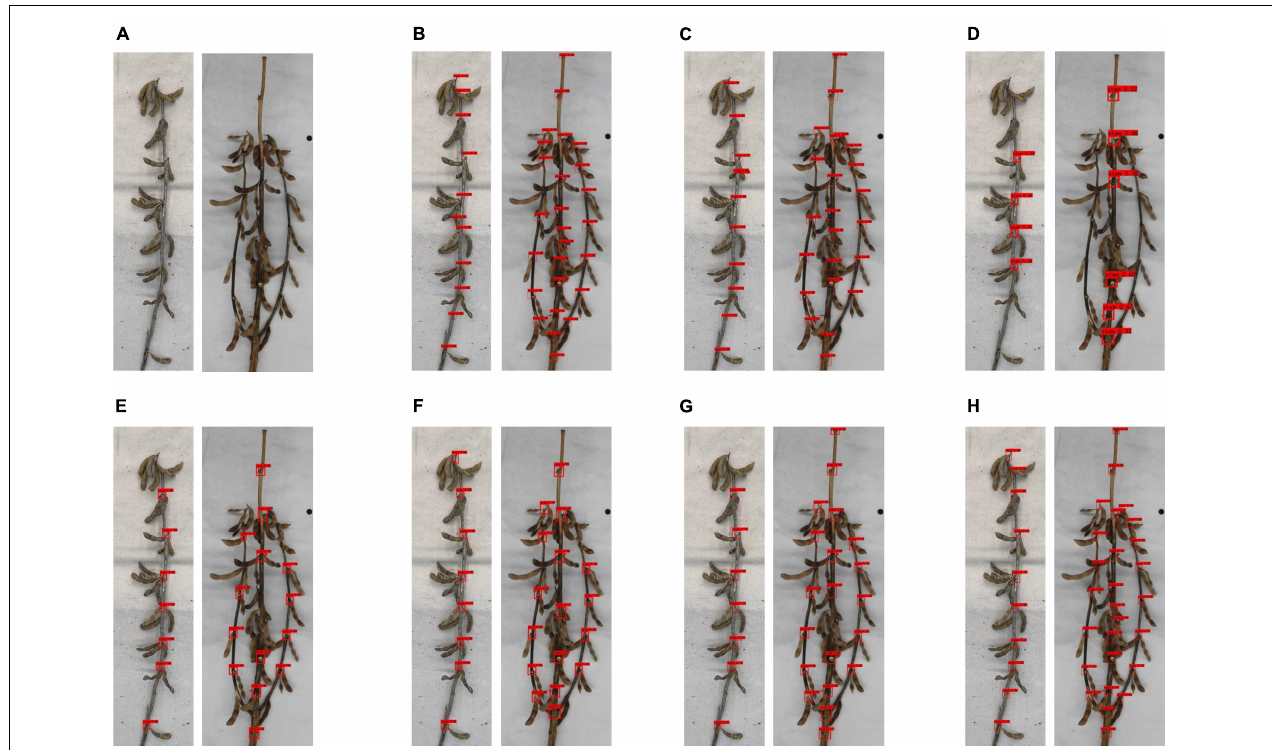
FIGURE 8 | Prediction effect of different networks on soybean plants: (A) original image, (B) detection results of Faster R-CNN (ResNet50), (C) detection results of Faster R-CNN (VGG16), (D) detection results of SSD network, (E) detection results of YOLO v3 (EfficientNet) network, (F) detection results of YOLO v3 network, (G) detection results of YOLO v4 network, and (H) detection results of YOLOX network.